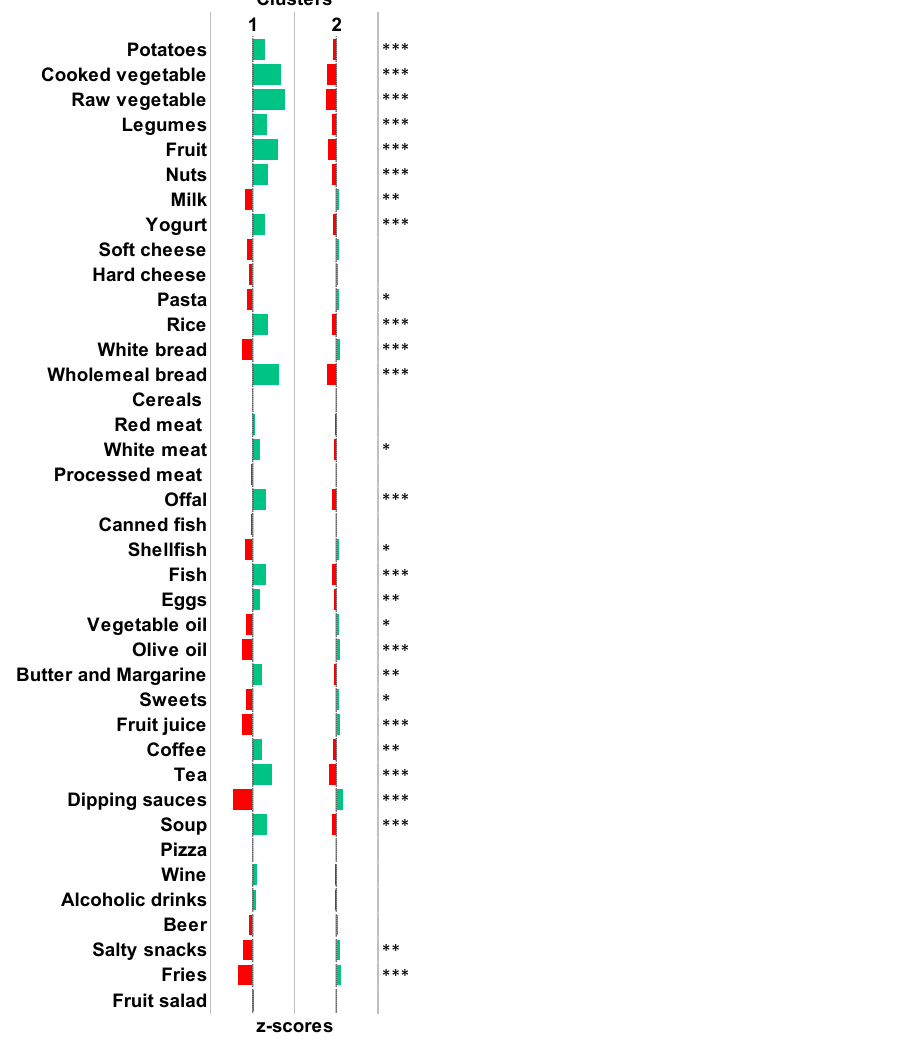
Figure 3. Comparison of dietary intakes between clusters. Green bars represent food items that pos- itively characterized the cluster. Red bars represent food items that negatively characterized the cluster. According to Student(cid:31)s t -test, results are reported as *** for p -values < 0.001; ** for p -values < 0.01; * for p -values < 0.05.